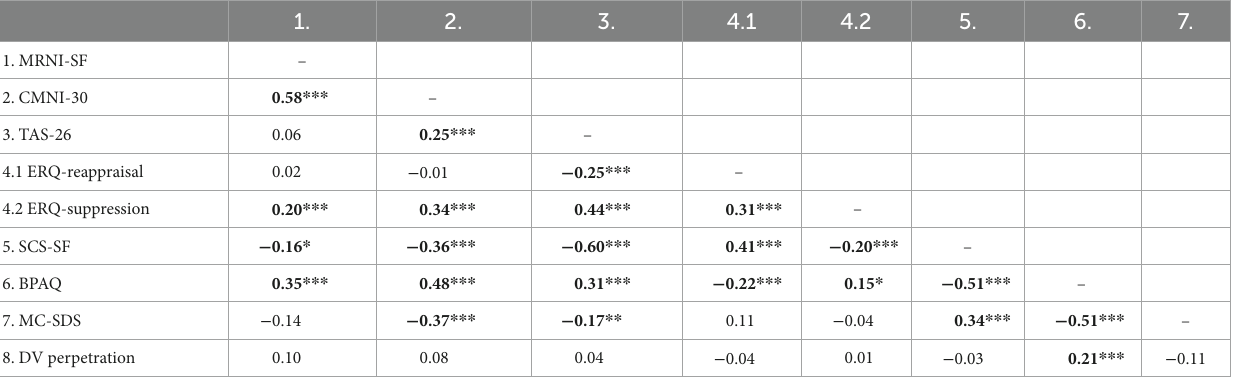
TABLE 2 Pearson’s correlation coefficients of the